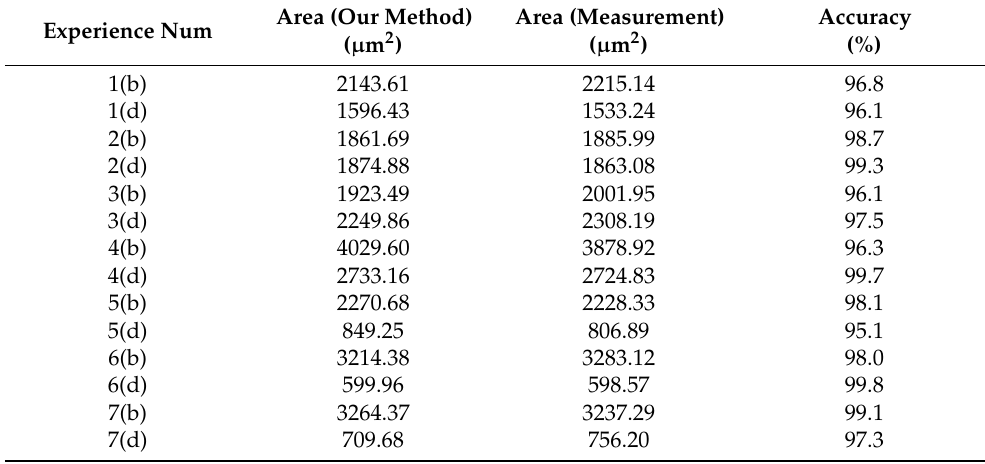
Table 3. Abrasion